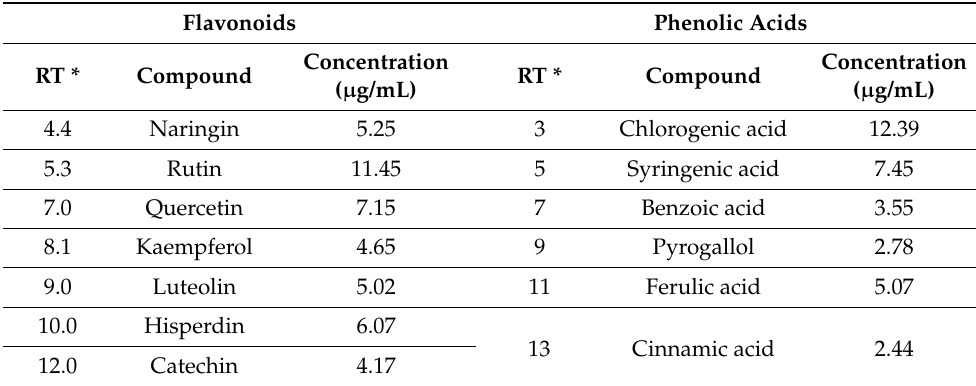
Figure 1. Collected latex (arrow direction to white latex secretion) from stipe of fruits. Table 1. Flavonoids and phenolic contents of T. peruviana latex.